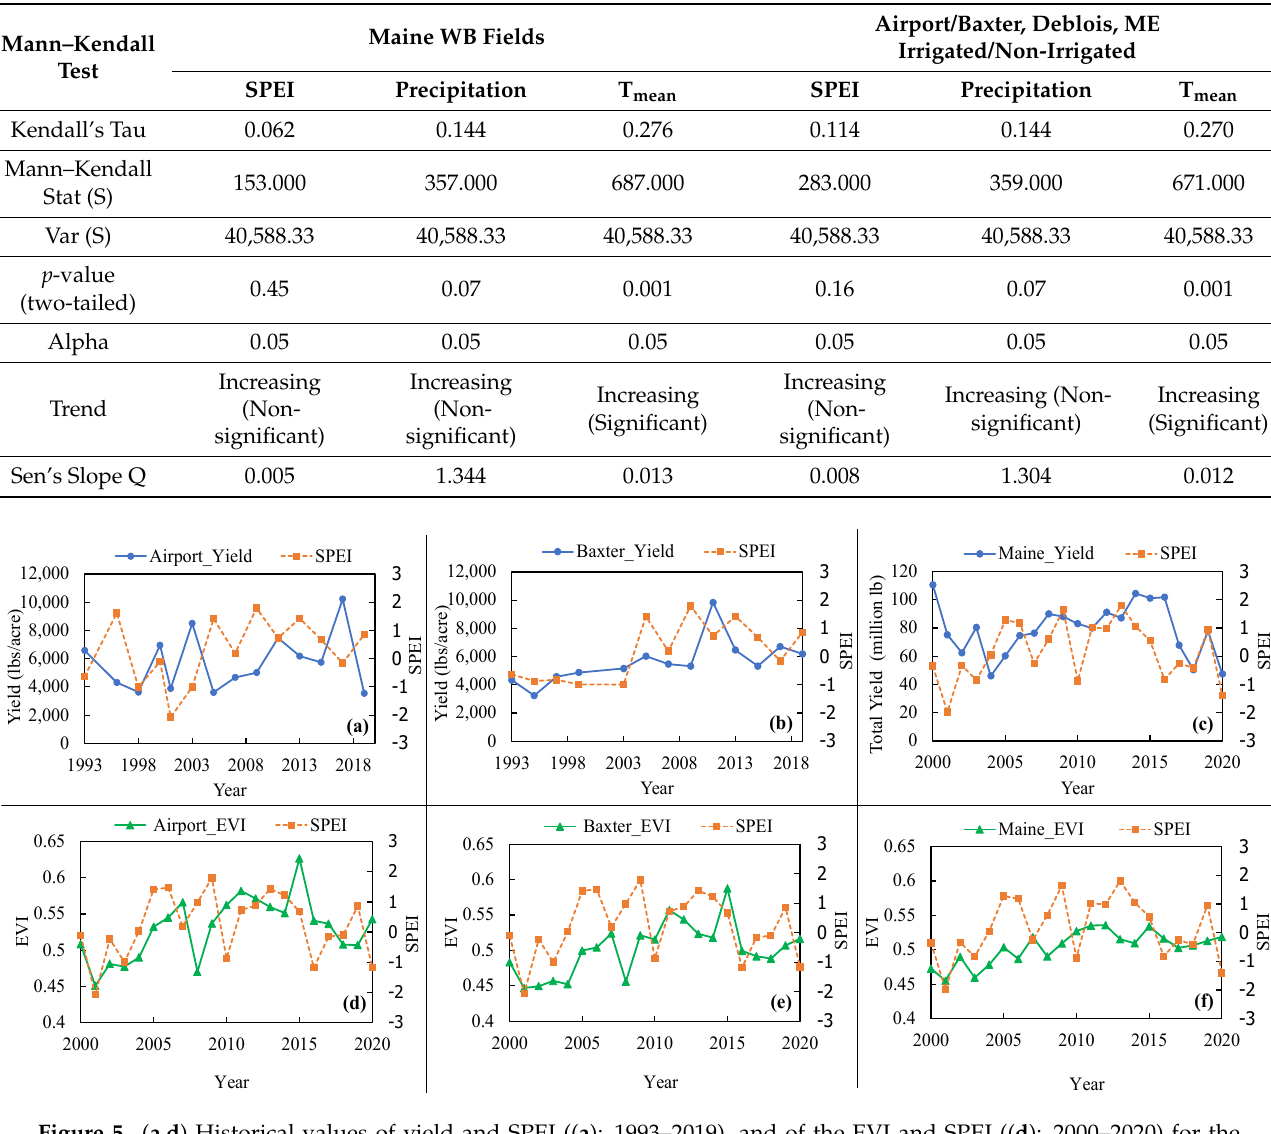
Table 1. Sequential Mann–Kendall trend analysis of the standardized precipitation-evapotranspiration index (SPEI), precipitation and mean temperature (T mean ) at different wild blueberry study zones: Airport/Baxter wild blueberry fields (Deblois, ME), and Maine wild blueberry fields (Washington and Hancock counties, ME). Here, the SPEI refers to SPEI_6 of September. It represents the SPEI of the growing season (April–September) and indicates water conditions and drought severity. T mean represents the average air temperatures during the growing period (May–September).